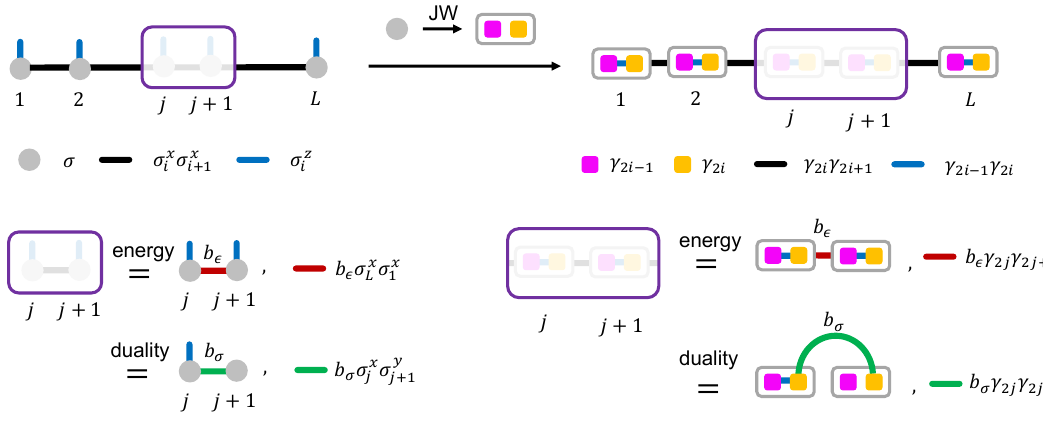
Figure 2 . Schematic of the defect Hamiltonians in the spin and fermionic pictures. The JW trans- formation maps each spin to a pair of Majorana fermions [see eq. (2.5)]. The ferromagnetic couplings in the spin picture leads to couplings between Majorana fermions on neighboring sites (black links), while the transverse field corresponds to couplings between Majoranas within each site (blue links). The altered ferromagnetic coupling of the energy defect is indicated in maroon. The duality defect entails a σ x σ y coupling indicated by a green bond, together with a missing transverse field on j j +1 site j + 1 . In the fermionic picture, this leads to a Majorana zero mode ( γ 2 j +1 ). The other zero mode is delocalized throughout the system [see eq.